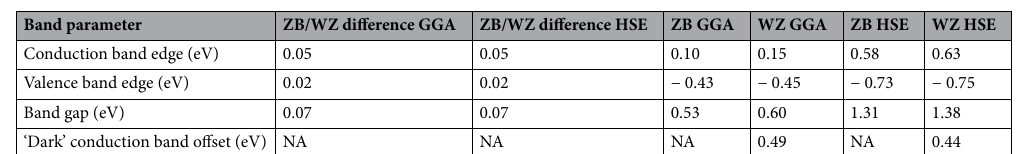
Table 1. Band structure parameters extracted from the band structures shown in Fig. 2 and Supplementary Fig. 9.